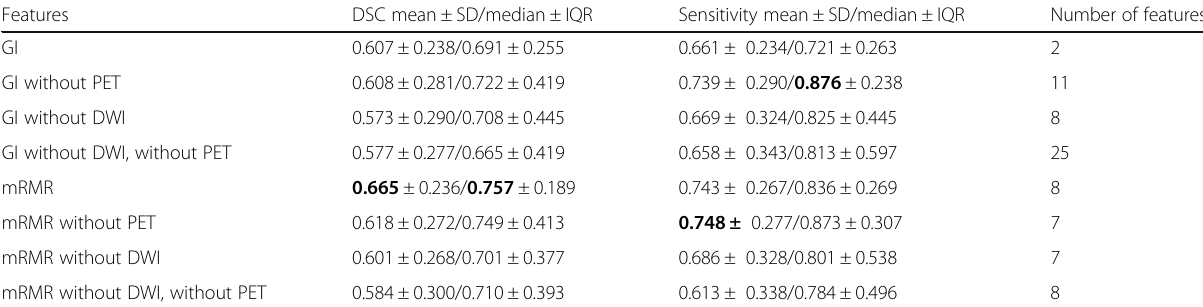
Table 3 Automatic segmentation performance in terms of DSC and sensitivity